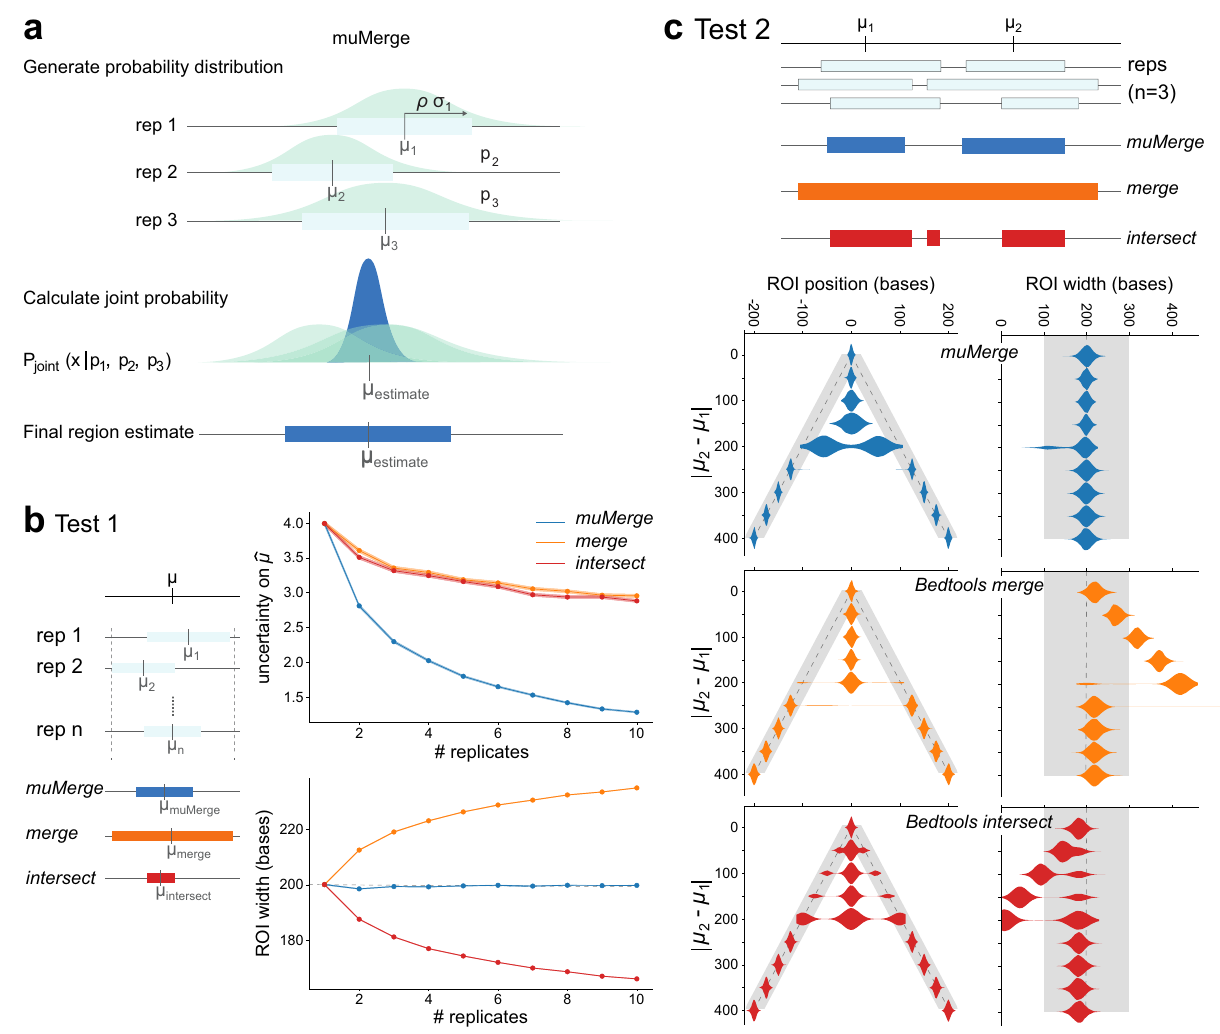
Fig. 2 muMerge precisely combines multiple samples into consensus ROIs. a A schematic for the muMerge method. Each sample region (light blue box) is represented by a probability distribution (green, Eq. (1), with centers μ i and stdev ρσ i ), which are combined into a joint probability distribution (dark blue peak, Eq. (2)) from which the fi nal ROI estimates are inferred (dark blue bar). b Test 1 demonstrates the position and width accuracy of a calculated ROI for a single locus, μ , as the number of sample replicates are increased (from one to ten). The three methods, bedtools merge (orange), bedtools intersect (red), and muMerge (dark blue), for generating ROIs from multiple samples are compared. With muMerge the uncertainty on ^ μ (i.e., the standard deviation of the ; μ ; μ distance between the ground truth position, μ , and its estimate, ^ μ 2 f μ g ) decreases quickly while the estimated ROI width remains muMerge merge intersect essentially constant. The standard error, indicated by colored shading, is less than the line width in most cases. c Test 2 demonstrates the precision of the calculated ROI for two closely spaced loci, μ 1 and μ 2 , as the spacing between them is increased. In this case, muMerge transitions from a single locus to two distinct loci more gradually (violin plots, ROI position) and the estimated ROI widths do not deviate from the expected value (violin plots, ROI width), unlike merge and intersect . In all cases, expected value and variance used for the simulations is indicated by dashed grey lines and shading, respectively. For further detail on the results of Test 1 and 2 and how the simulations were performed, see Supplementary Fig. 4 and Methods section "muMerge : Simulating replicates for calculation of